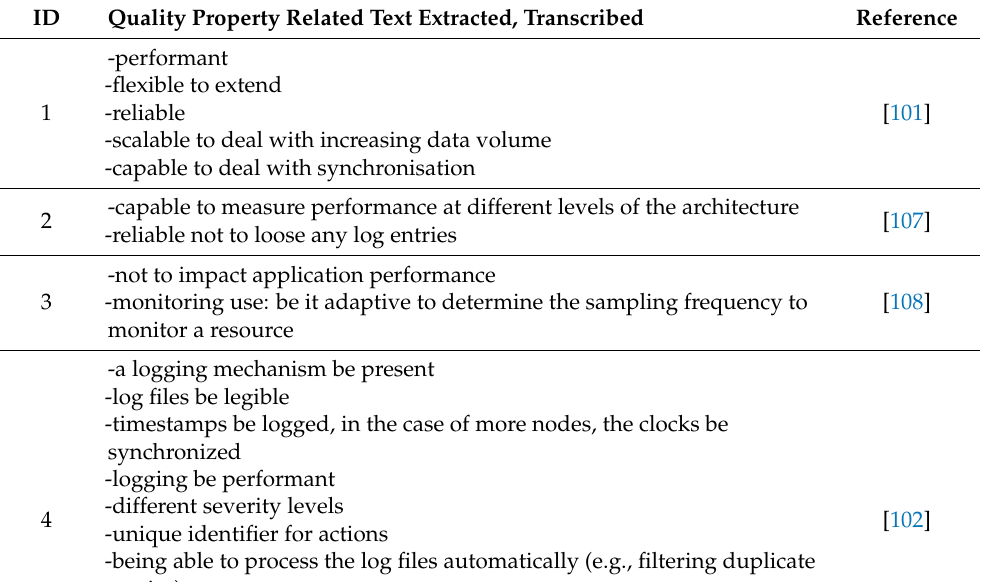
Table A4. Data Coding, Transcription: Quality Properties from the